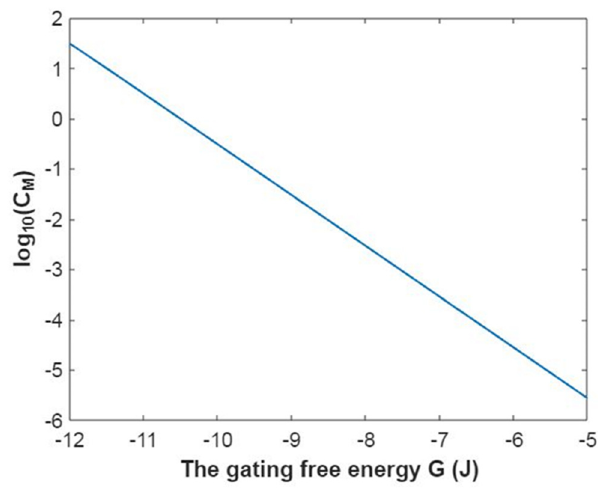
Figure 20. The relationship between gating free energy and the common logarithm of the membrane conductance of potassium ions according to the Boltzmann distribution at membrane potential of − 0.087 V and over a gating free energy range from − 12 J to − 5 J.